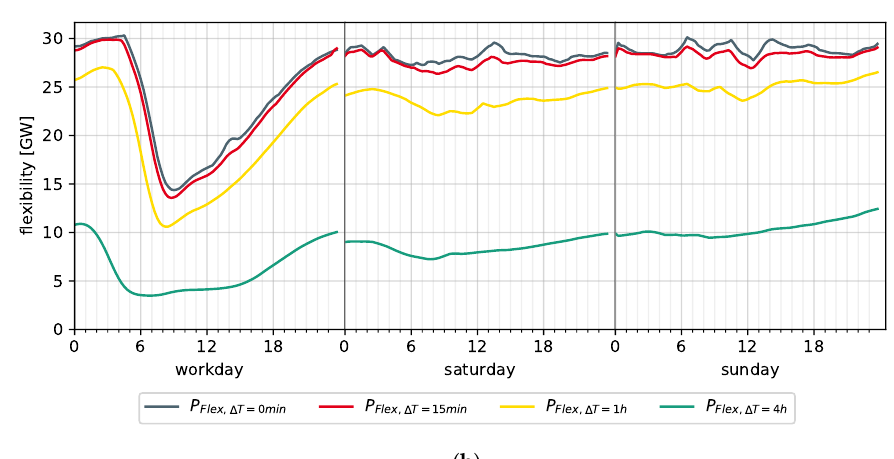
Figure 12. Impact of different product lengths (minimal provision period) on the available positive flexibility in the ( a ) sum- mer and ( b ) winter of the year